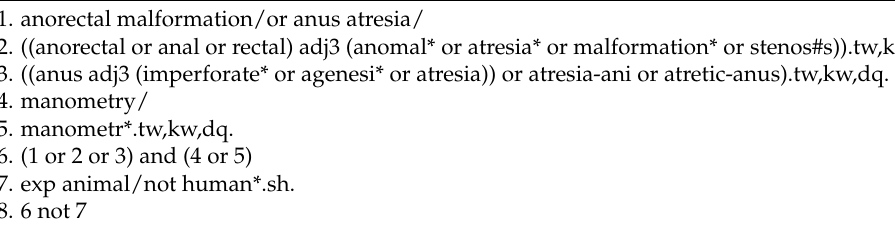
Table A2. Sample search strategy: